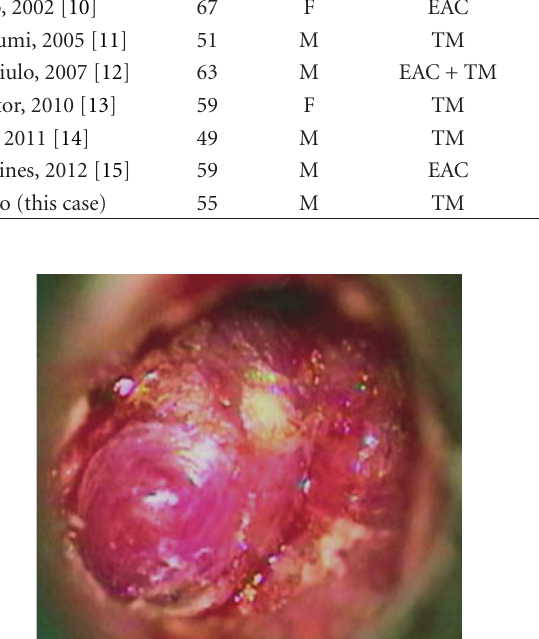
Figure 2: Computed tomography scanning without means of contrast. A 3mm soft tissue mass is localized in the superior part of ear drum in correspondence of malleus with no present signs of erosion. Middle ear cavity and the other ossicles appeared normal. occurs predominantly in adulthood (average age 56), with